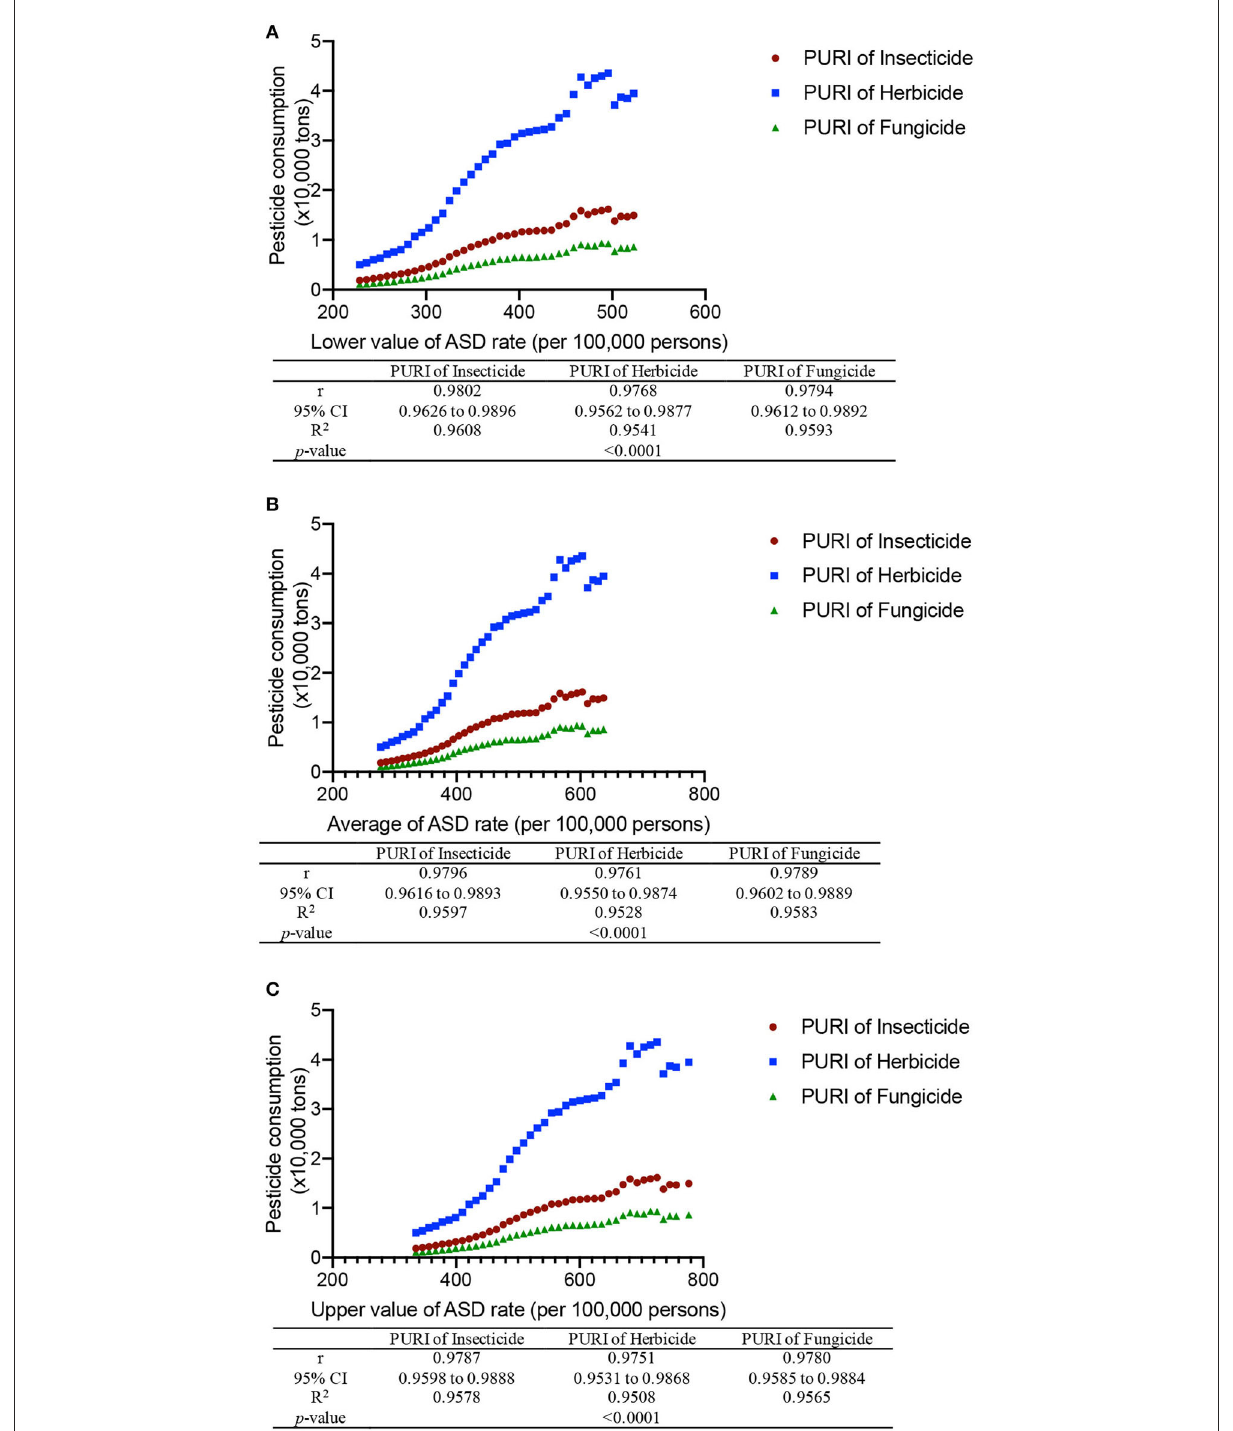
FIGURE3 Pearson’s correlation analysis of the relationship between ASD rate and pesticide usage risk index (PURI) in China from 1990 to 2030. (A) The relationship between the lower limitation of ASD rate and PURI. (B) The relationship between the average of ASD rate and PURI. (C) The relationship between the upper limitation of ASD rate and PURI. Pesticides include fungicide, herbicide, and insecticide. PURI = pesticide usage (kg/person) × (rural/urban population ratio) × 3.5. Spearman’s Rho is a non-parametric test to evaluate the strength of association between the two variables, where r = 1 means a perfect positive